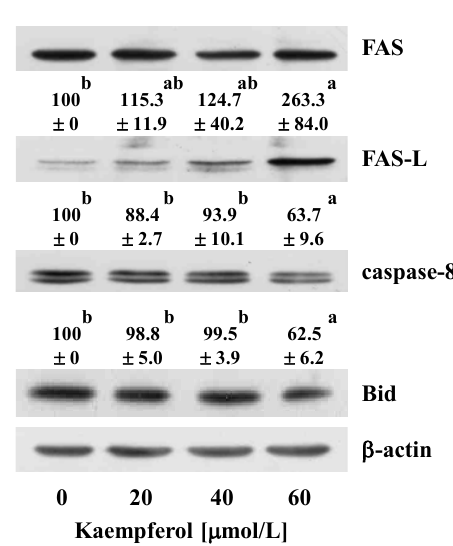
Figure 5. Effect of kaempferol on extrinsic apoptotic pathway. Cells were treated with various concentrations of kaempferol for 48 h. ( A ) Total cell lysates were prepared and analyzed via Western blotting with antibodies against the indicated antibodies. The relative abundance of each band was quantified and the control levels (0 μmol/L kaempferol) were set at 100%. The adjusted mean ± SEM ( n = 3) of each band is shown above each blot; ( B ) Caspase-8 activity was measured using Caspase-8 colorimetric assay kit in accordance with the manufacturer’s instructions (Clontech, Mountain View, CA, USA). Each bar represents the mean ± SEM ( n = 4). Means without the same letter (a, b or c) are significantly different ( p <